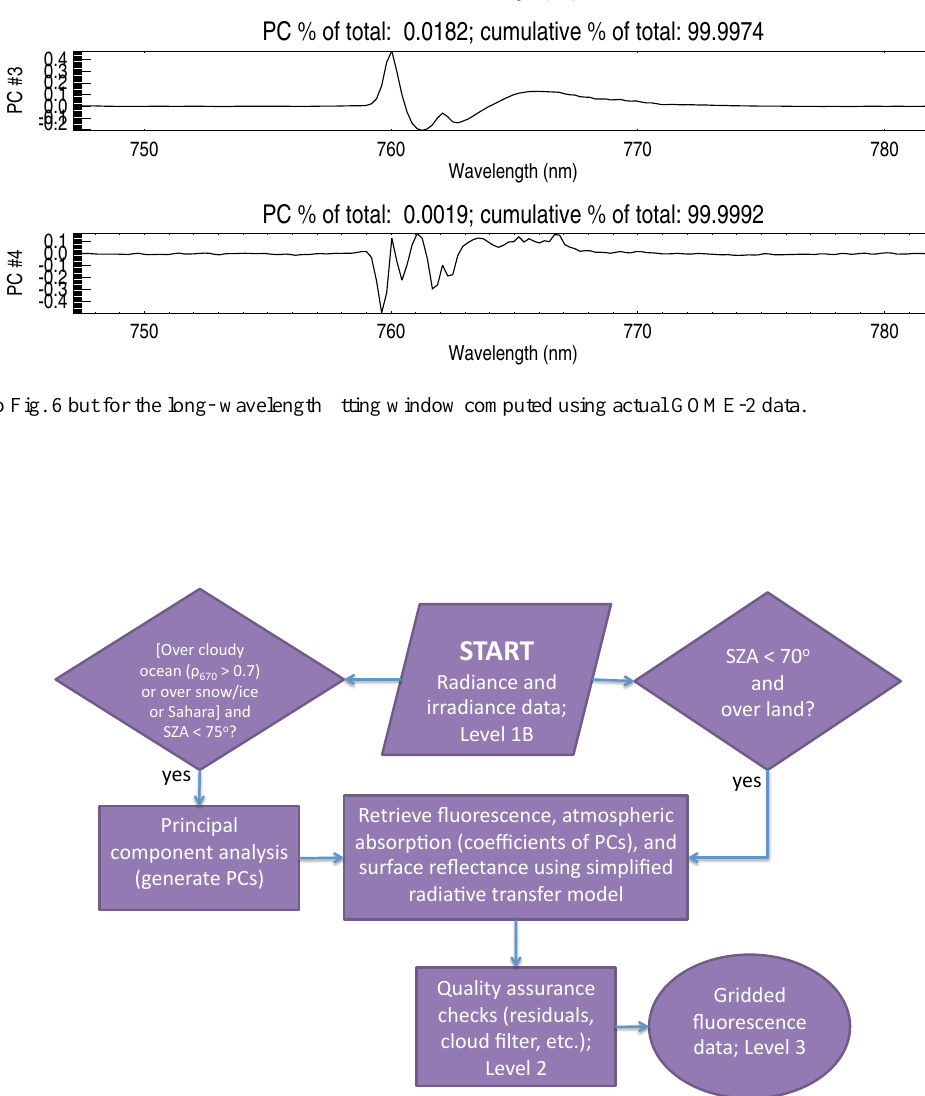
Fig. 9. Flow diagram showing the overall processing scheme for GOME-2 fluorescence retrievals.